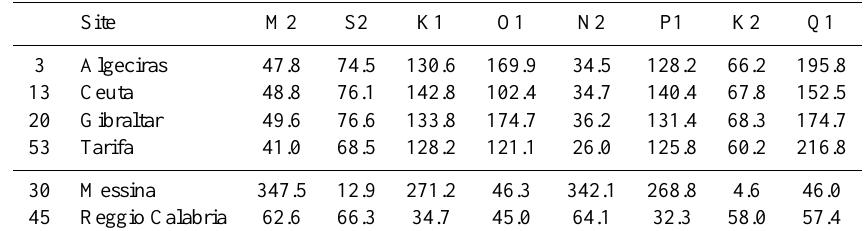
Table 5. Phase lag of tide-gauge observations close to Straits of Gibraltar (upper) and Messina (lower).